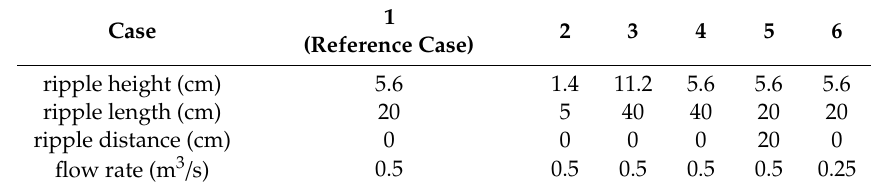
Table 1. Simulation cases including ripple geometries and flow rates .